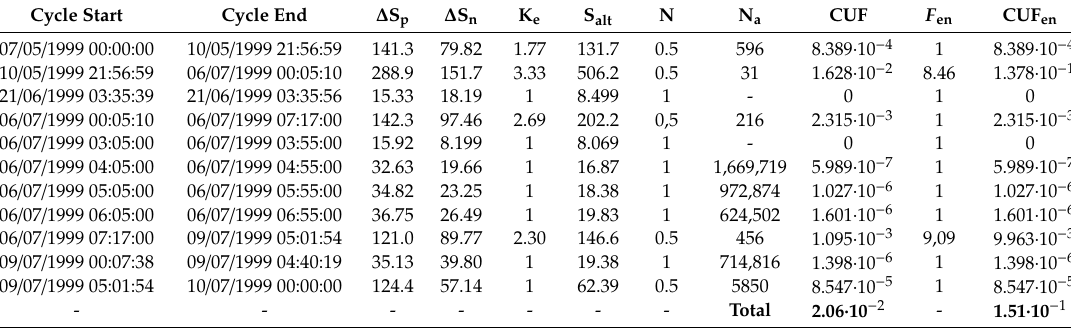
Table A4. Calculations performed to derive CUF and CUF en in the second sequence of design transients. ∆ S ∆ S + secondary stress range in the pair; K p : total stress range in the pair; n : primary e : elastic-plastic penalty factor; S alt : alternative stress; N: number of cycles; N a : maximum number of allowable